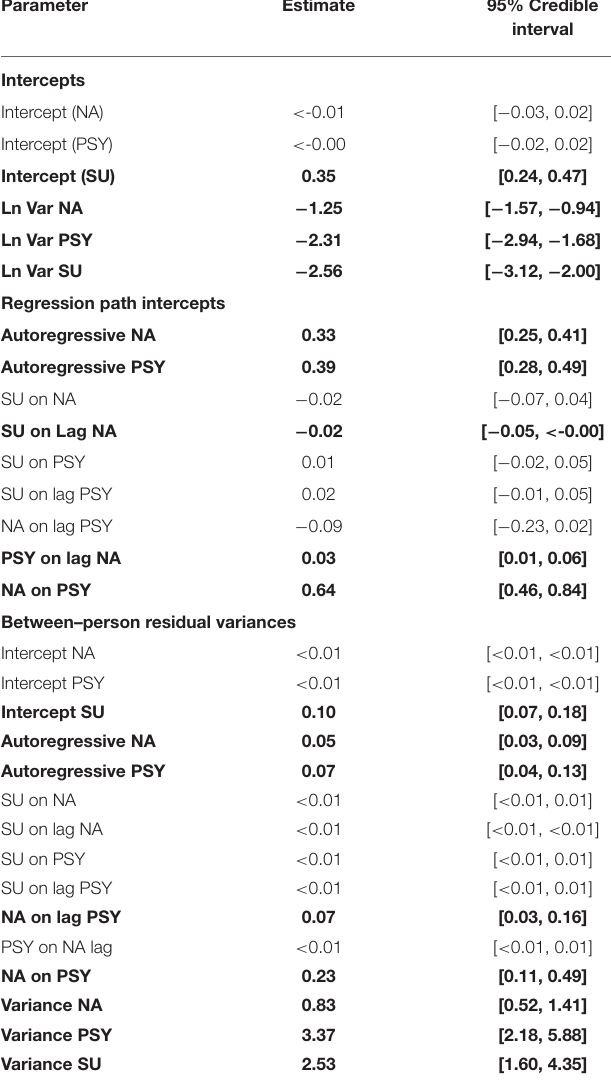
TABLE 3 | Posterior median parameter estimates with 95% credible intervals for MVAR model of substance use, psychotic symptoms, and negative affect.